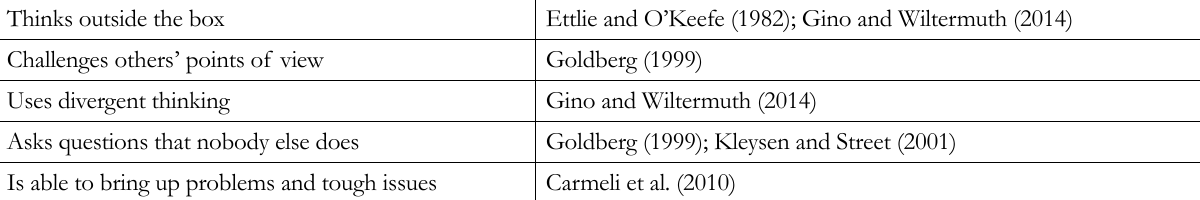
Table 7. Behaviours showing “thinking differently”